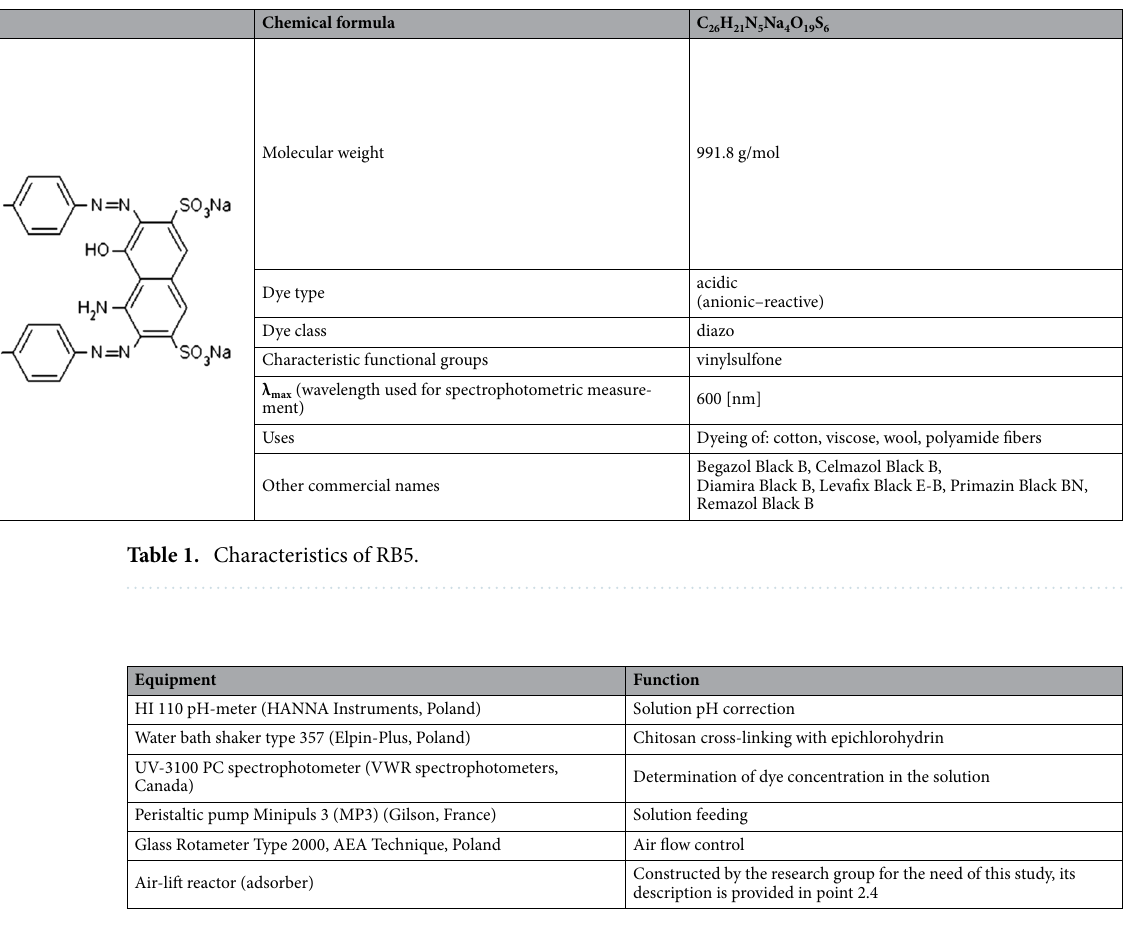
Table 2. Laboratory equipment used in the